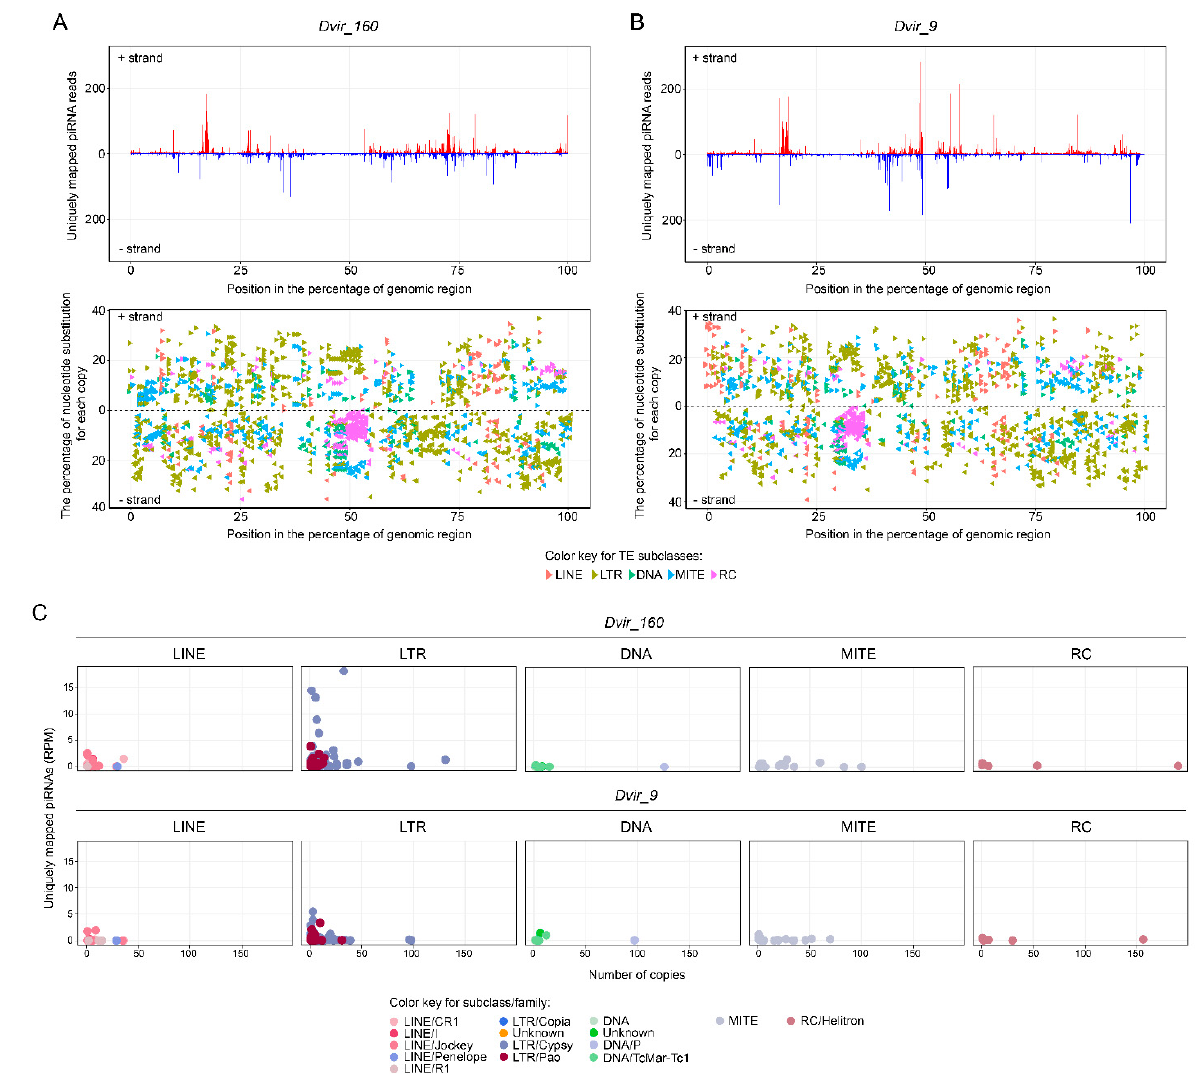
Figure 6. Comparative landscape of piRNA mapping of the studied heterochromatic region in D. virilis strains 160 and 9. ( A , B ) (Top) The coverage of uniquely mapped piRNAs on [+] and [ − ] DNA strand of strain 160 and 9, respectively. (Bottom) The content of transposable elements in the considered heterochromatic regions of D. virilis strains 160 and 9. Subclasses of transposable elements are indicated by different colors. The orientation of transposable elements is shown relative to [+] and [ − ] strands. Plots were created by per-base coverage of mapped reads. ( C ) The number of unique piRNAs derived from a genomic region estimated for each transposable element (the y-axis). The number of copies for each transposable element is shown on the x-axis. Each dot represents one transposable element.